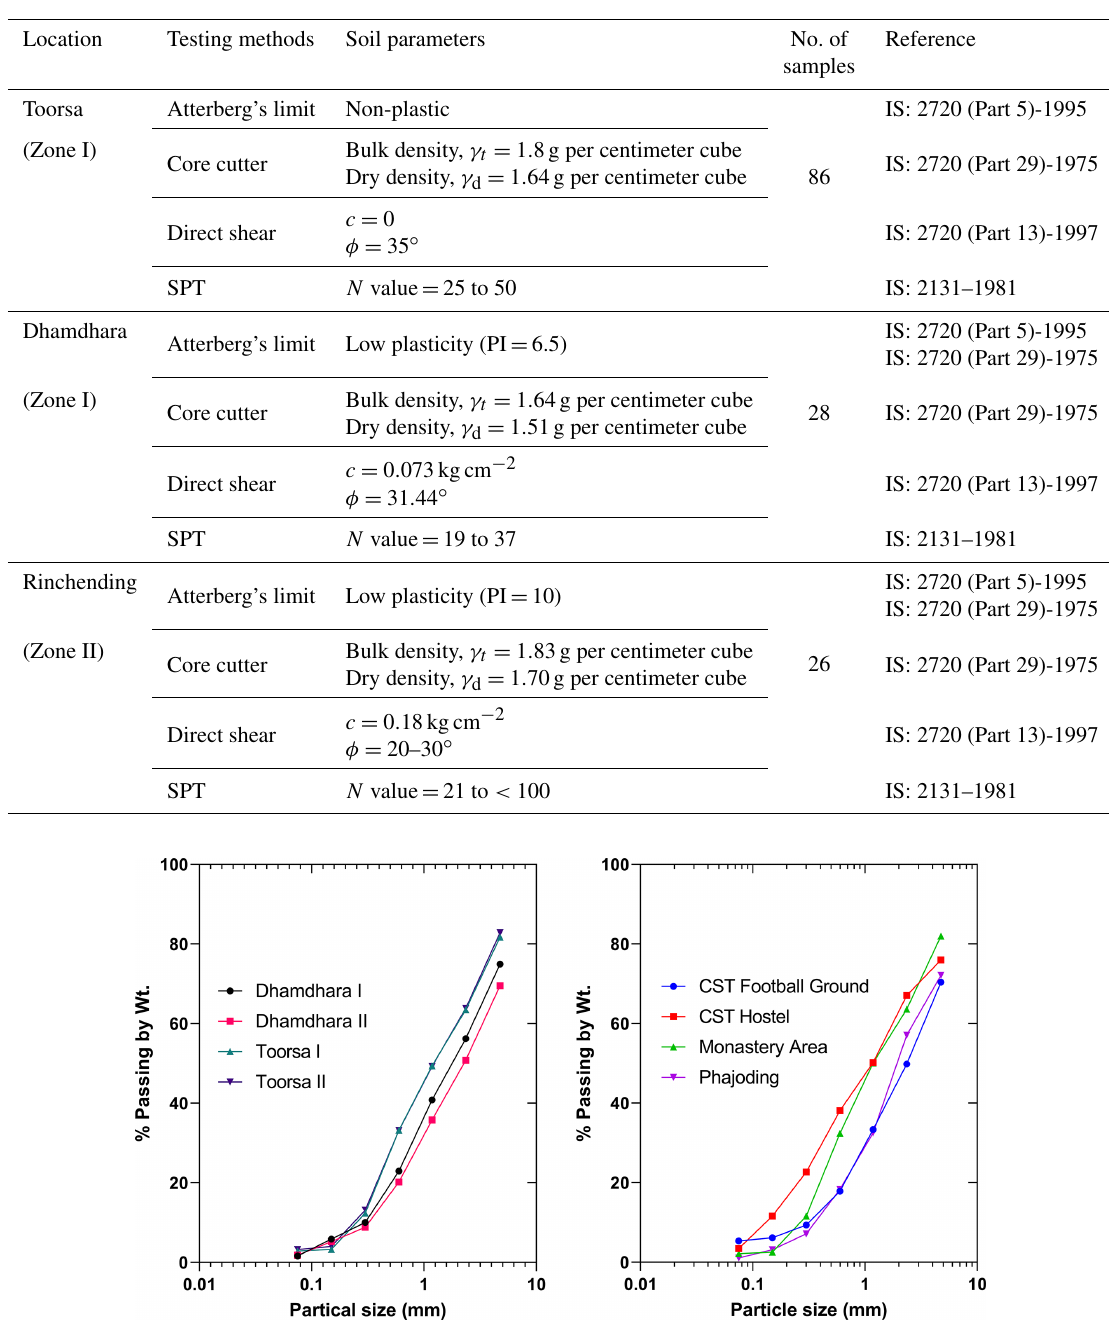
Table 1. Average soil parameters in the study area.